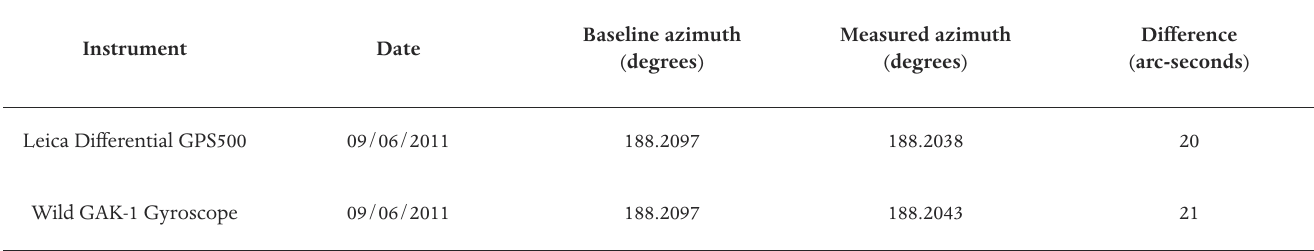
Table 3. Comparison of azimuth determination for Wild GAK-1 gyroscope and Leica GPS500.